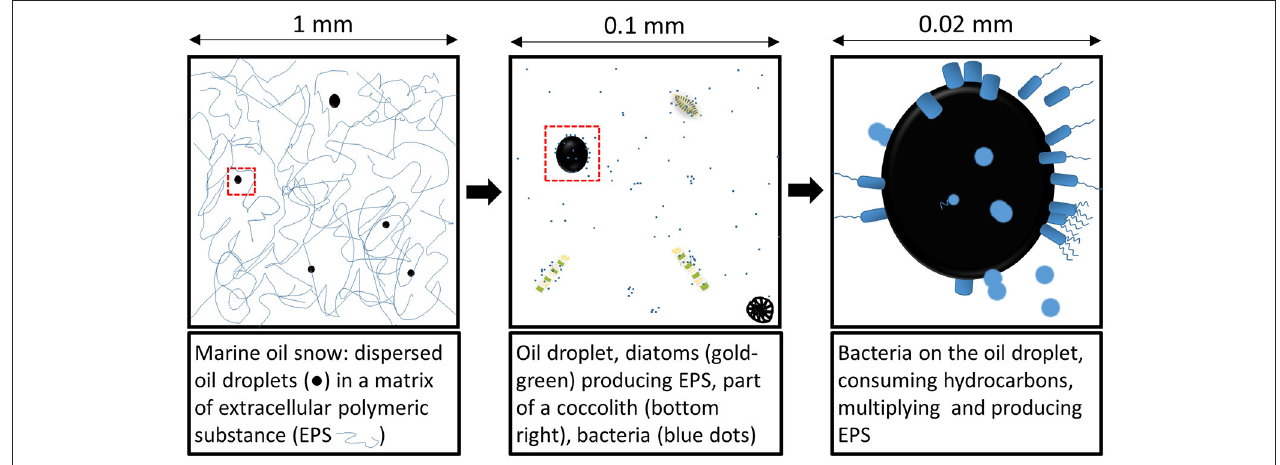
FIGURE 3 | Schematic representation of microbes and dispersed oil droplets in marine snow at different